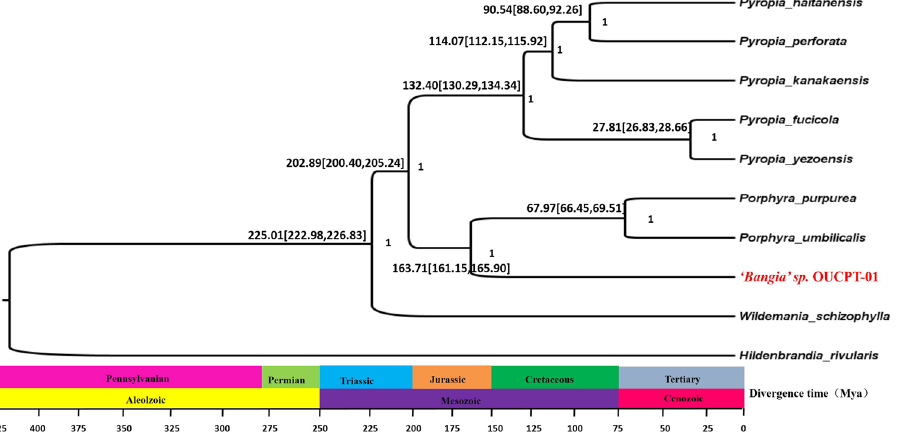
Figure 6. Chronogram showing Bayesian estimates of the divergence times among the Rhodophyta. Bottom: geologic time scale. The Bayesian posterior probabilities, the 95% confidence interval of the divergence time, and the divergence time are shown above the